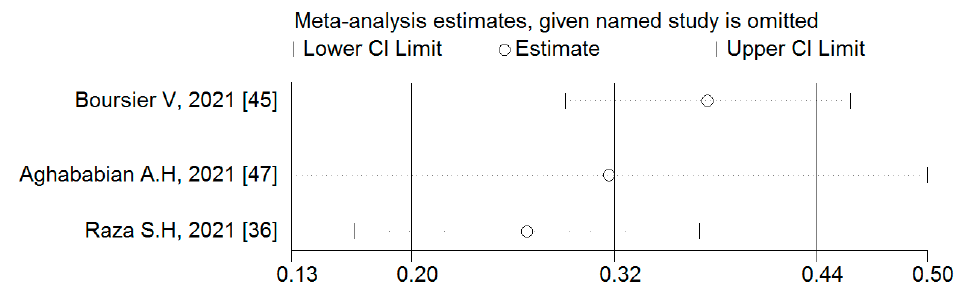
Figure 11. The sensitivity analysis plot assessing the small study effect in the estimated pooled Fisher’s z-score in the association between binge-watching and stress.